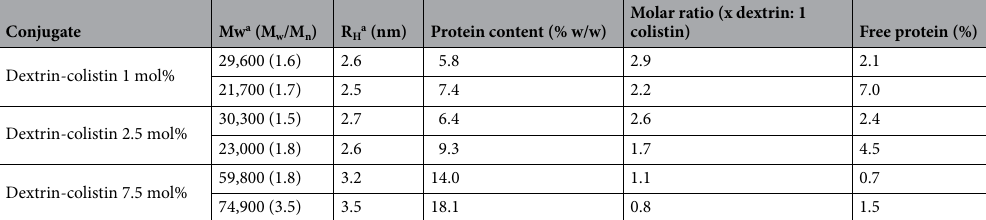
and RALS) detection and a Viscotek 2501 UV detector (210 nm). The column set consisted of an Ultrahydrogel guard column and two Ultrahydrogel 250 columns (7.8 mm × 300 mm) from Waters (Elstree, UK) in series, running at 30 °C with PBS buffer eluent and a flow rate of 0.7 mL/min. Samples (300 μL) were injected into a 100 μL loop. A polyethylene oxide standard (Mw = 23,964, Mn = 23,502, IV = 0.404) from Malvern Panalytical (Malvern, UK) was employed for the calibration set up. The characteristics of dextrin-colistin conjugates used in these studies are summarized in Table 2. Stability sample preparation. Stability during storage. Three primary batches of colistin sulfate, CMS and dextrin-colistin conjugates were dissolved in PBS at 3 mg/mL and stored at − 20, 4, 21 and 37 °C for 0, 1, 3, 6, 9 and 12 months. In addition, to test the effect of repeated freeze–thaw on stability, a separate set of solutions were stored at − 20 °C and defrosted for 1 h at 20–22 °C weekly for 5 cycles. Samples were analyzed using FPLC (free drug) and GPC (saccharide release) and antimicrobial activity, UV/vis absorbance and protein content (bicinchoninic acid (BCA) assay) of the samples stored for 12 months was assessed. Fast protein liquid chromatography. FPLC was performed using an ÄKTA Purifier from GE Healthcare (Amer- sham, UK) column with a UV detector and data analysis using Unicorn 5.31 software from GE Healthcare (Amersham, UK). Samples (200 μL) were injected into a 100 μL loop at 0.5 mL/min, connected to a prepacked Superdex 75 10/300 GL column with PBS buffer eluent. The proportion of free colistin was calculated by inte- grating the peaks corresponding to conjugate and free drug. Gel permeation chromatography. GPC was performed using an Ultrahydrogel guard column and two Ultrahy- drogel 120 columns (7.8 mm × 300 mm) from Waters (Elstree, UK) in series, connected to a Jasco PU-1580 HPLC pump with PBS buffer eluent and a flow rate of 1 mL/min. Samples (300 μL) were injected into a 100 μL loop and the eluate was monitored using a Jasco MD-2010 multi-wavelength UV detector (210 and 280 nm) and